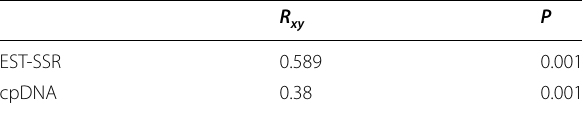
Table 6 Summary for Mantel tests